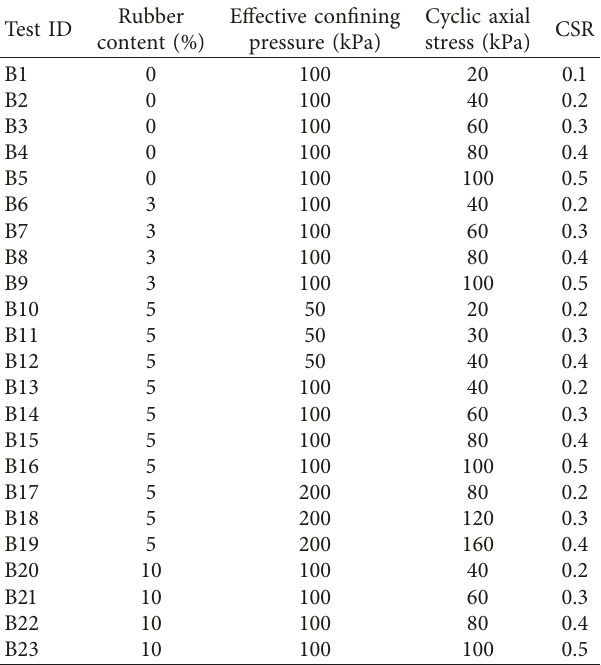
Figure 3: Optical microscope images. (a) Contact form between the sand and rubber particles. (b) Surface state of sand. (c) Surface state of rubber. Table 2: Test cases for the cyclic triaxial